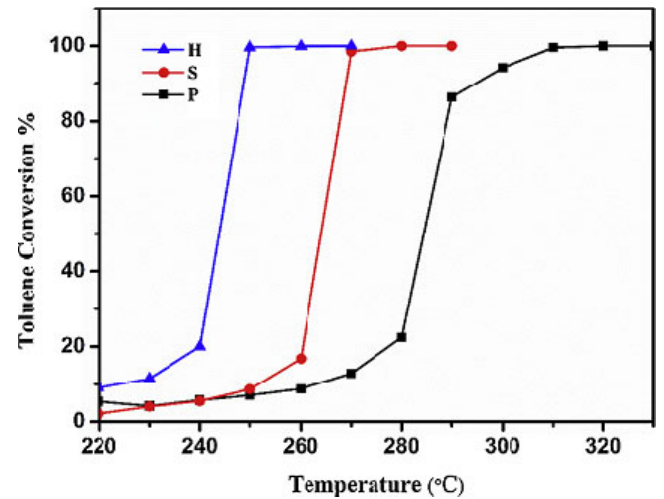
Figure 8. Catalytic performance of the synthesized Co 3 O 4 as a function of reaction temperature for toluene oxidation under the following conditions: toluene 500 ppm, O 2 /N 2 20 vol%, total flow rate = 100 mL/min, WHSV = 60,000 mL/(g h). Reprinted with permission from Ref. [77]. Copyright 2020